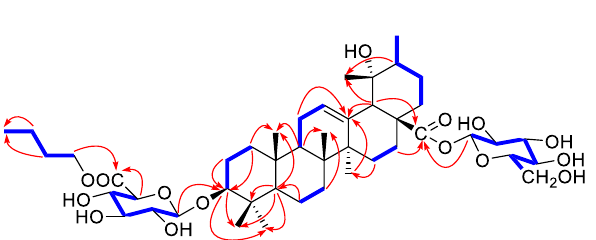
Fig. 1 Structures of 1 and 2